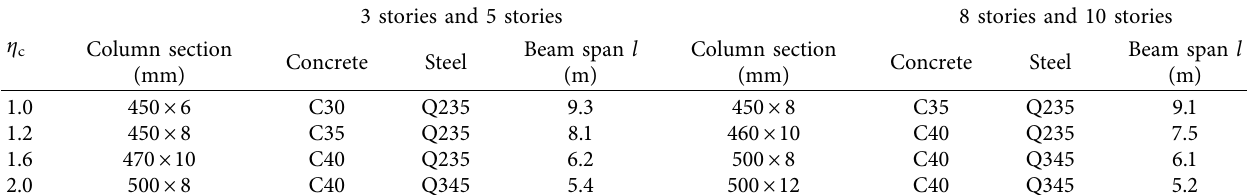
Figure 5: Mises stress nephogram. (a) CF11 (slip). (b) CF11 (no slip). (c) CF12 (slip). (d) CF12 (no slip). Table 2: Information of